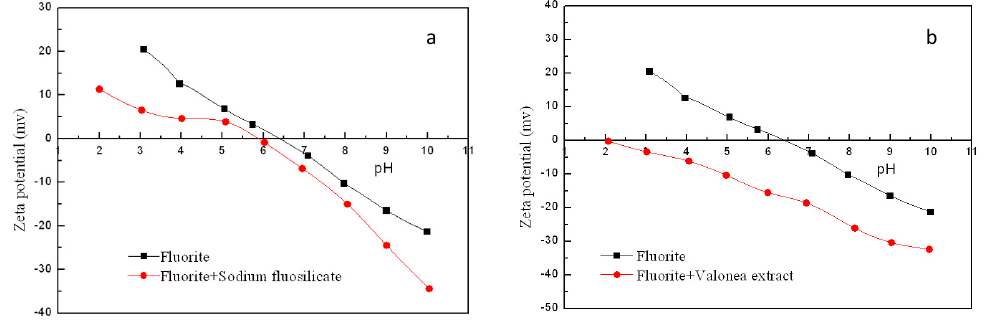
Figure 7. Effect of the addition of sodium fluosilicate ( a ) and valonea extract ( b ) on the zeta potential of fluorite (sodium fluosilicate dosage = 3 × 10 − 5 mol/L, valonea extract dosage = 4 × 10 − 4 g/L).